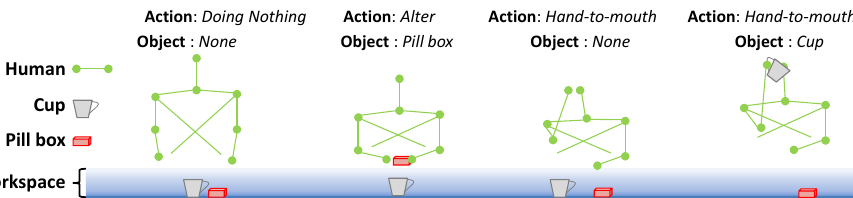
Figure 5. A conceptual representation of the expected actions and the manipulated objects for the medication adherence activity. Note that the sequence of the actions is not binding since the robot expects to identify all the triplets of actions/objects in order to draw a positive detection